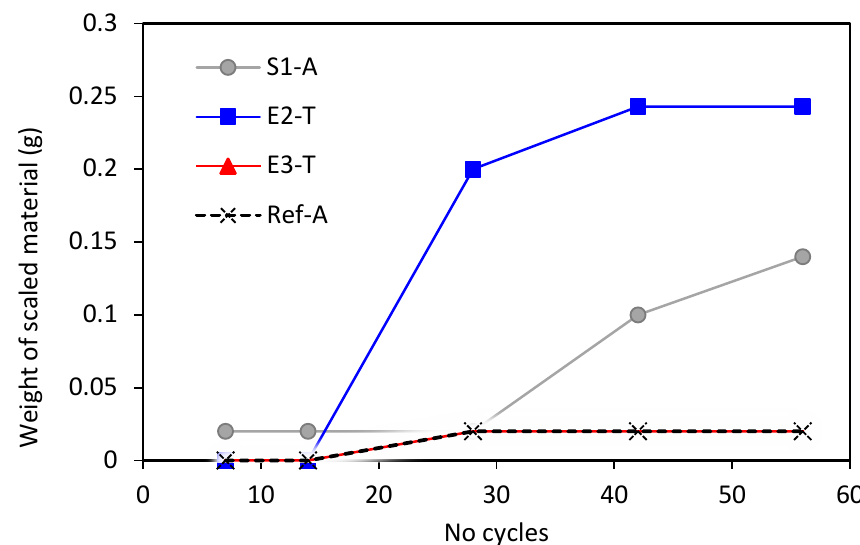
Figure 5. Weight of scaled material in selected samples. Even to the naked eye, the photographs of the photocatalytic specimens reproduced in Figure 6 clearly revealed that the coatings had worn away after freeze-thaw testing. When the asphalt was coated, the samples initially turned light grey, whilst after the cycles the colour reverted to the original black. The same effect was observed on the paving tiles, although the difference was less dramatic. The slurries also disappeared from the surface, especially in sample S2-A, in which the pre-test whiteness vanished, unveiling the black asphalt across the entire surface after the cycles.